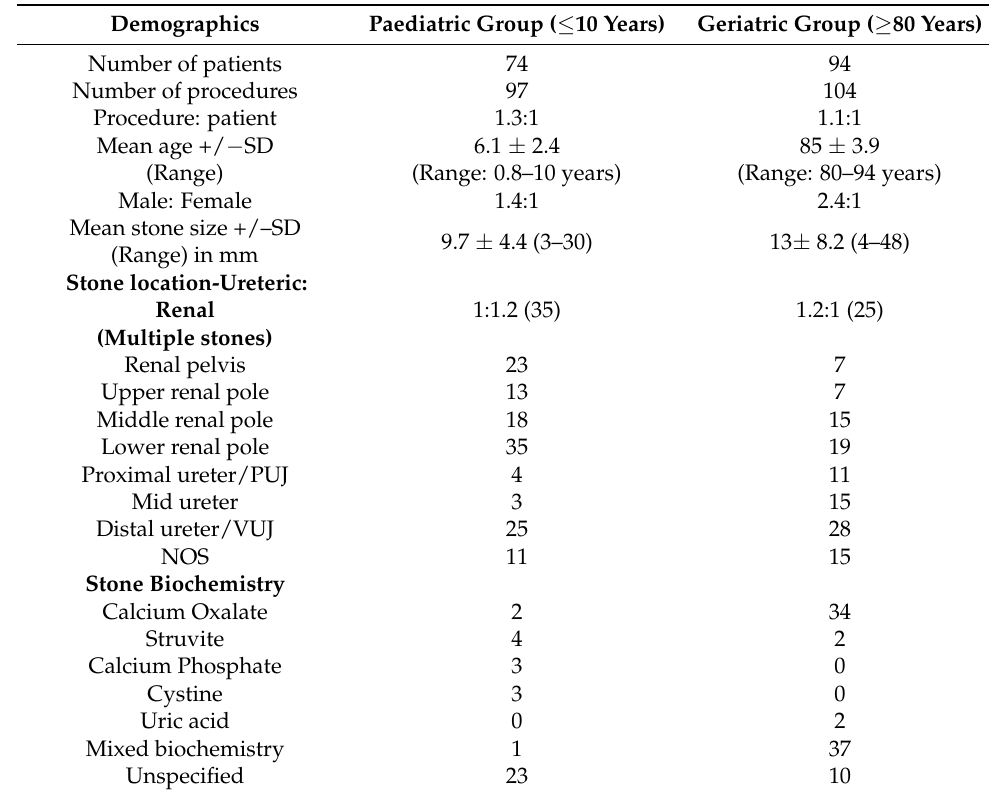
Table 1. Patient demographics in both patient cohorts undergoing FURSL (PUJ—pelvi-ureteric junction, VUJ—vesico-ureteric junction, NOS—not otherwise specified, ICU—intensive care unit and CD—Clavien–Dindo complication